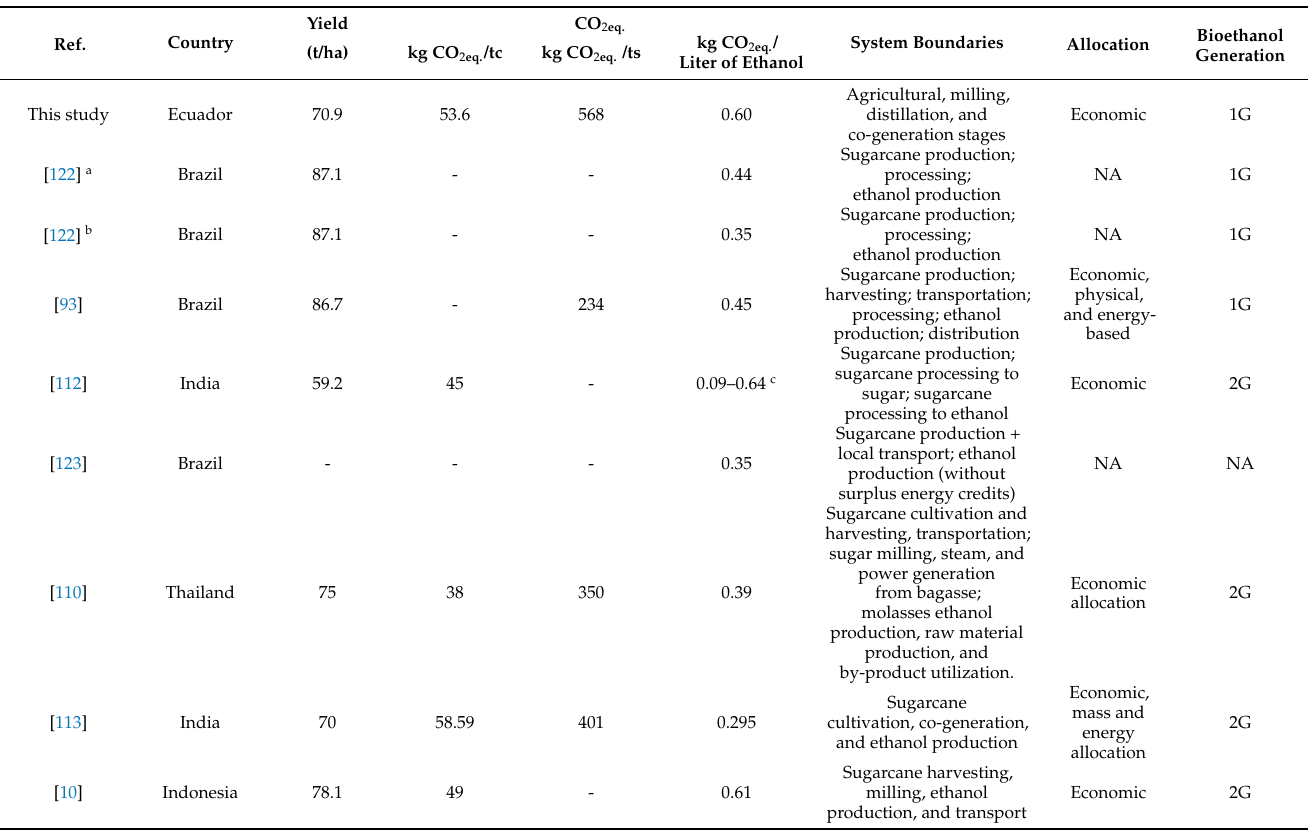
Table 6. GWP impact results at three different levels compared with the literature.